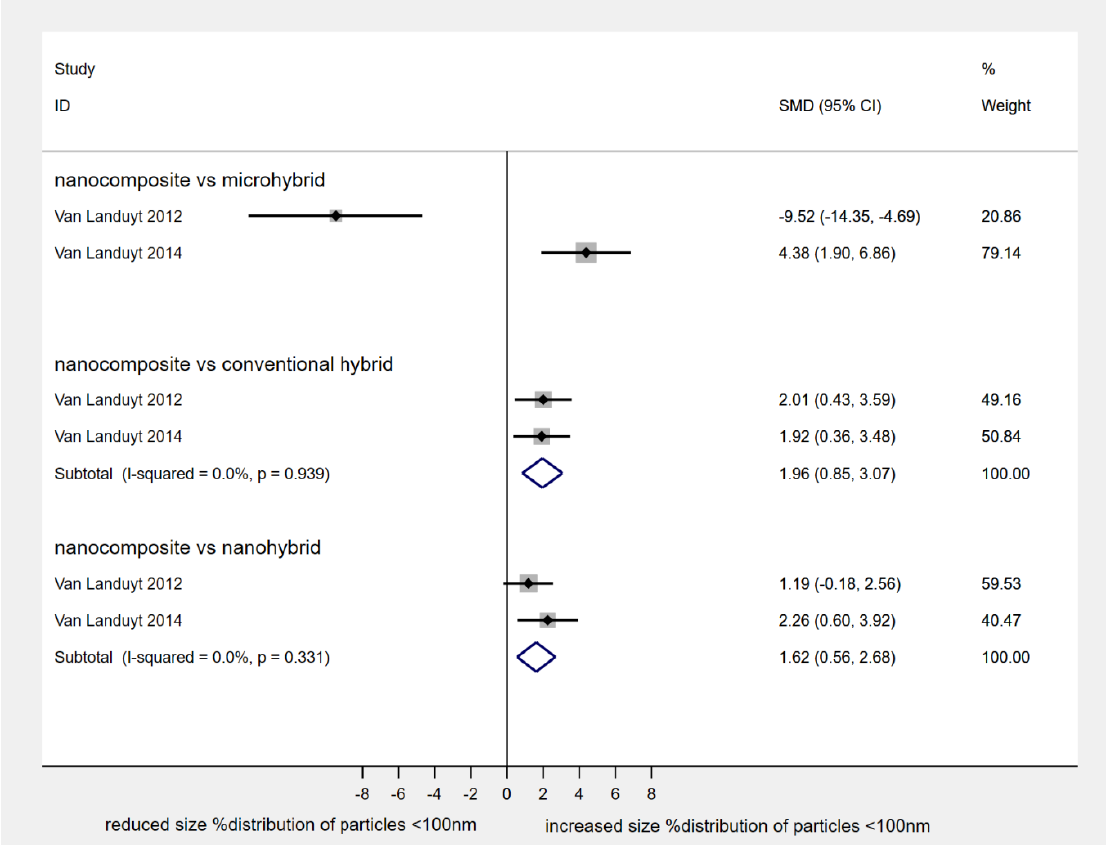
Figure 2. Standardized mean di ff erences in size % distribution of particles < 100 nm. (nanocomposite, Filtek Supreme XTE; microhybrid, Gradia Direct; conventional hybrid, Z100 MP; nanohybrid, Tetric EvoCeram).